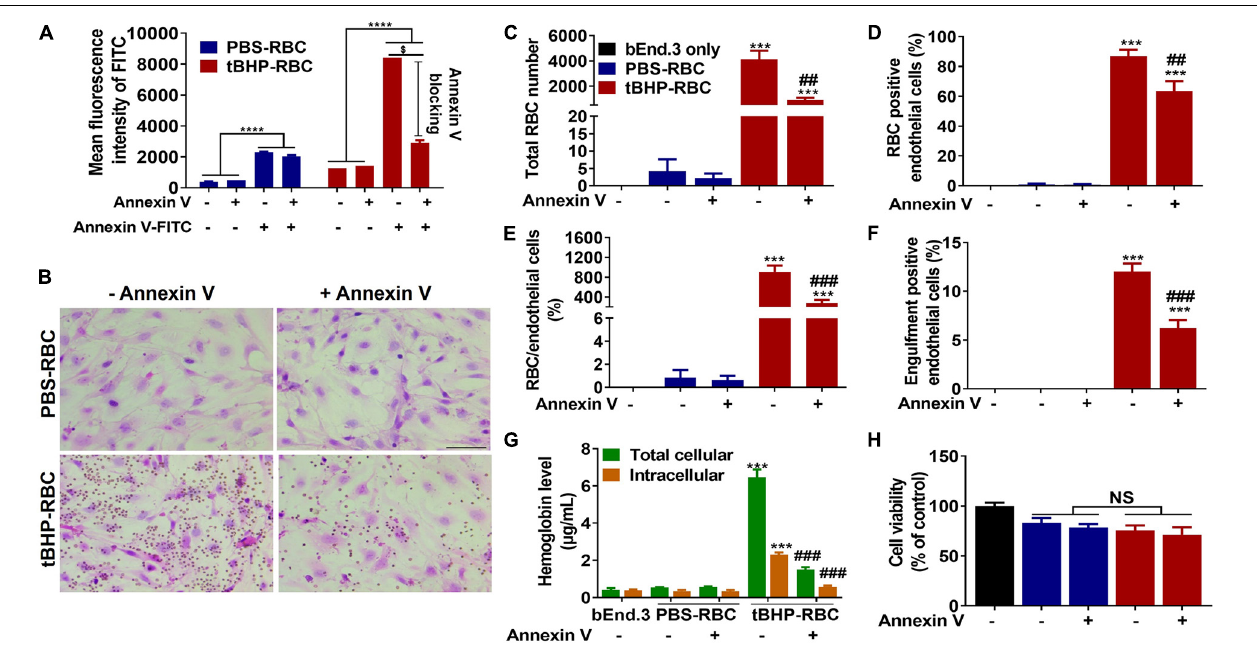
FIGURE 3 | Phosphatidylserine exposure plays an important role in brain endothelial erythrophagocytosis. Phosphatidylserine exposure of tBHP-RBCs was blocked by annexin-V (A) . Both RBC adhesion and engulfment were significantly suppressed by annexin-V (B–F) . The total cellular and intracellular hemoglobin levels were significantly reduced by annexin-V following a 48-h incubation (G) . Erythrophagocytosis did not alter brain endothelial cell viability following the 48-h incubation (H) . RBCs are seen as small red/brown dots, and bEnd.3 nuclei are stained purple with hematoxylin in panel (B) . Data are presented as mean ± SEM of three independent experiments done in duplicate. One-way (H) or two-way (A,C–G) ANOVA with Holm–Sidak post hoc test was used. *** p < 0.001, **** p < 0.0001 compared with the corresponding bEnd.3-only group and PBS-RBC group; ## p < 0.01, ### p < 0.001 compared with tBHP-RBCs without annexin-V; $ p < 0.0001. Scale bar = 50 µ m. NS is “not